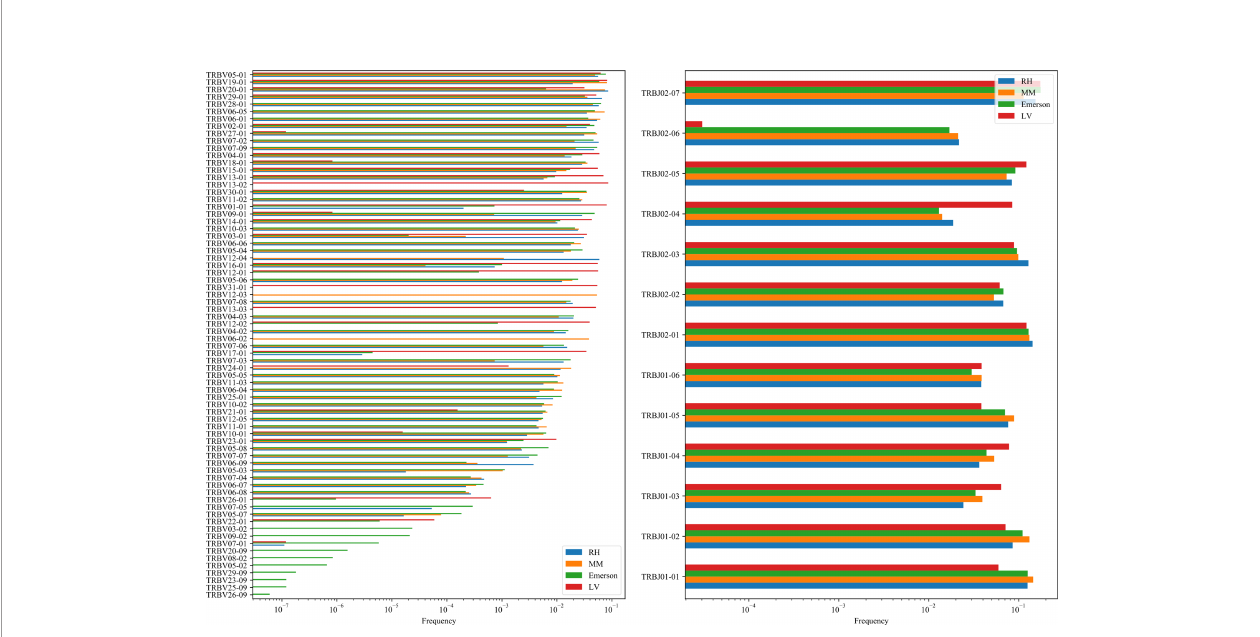
FIGURE 9 | V b (A) and J b (B)